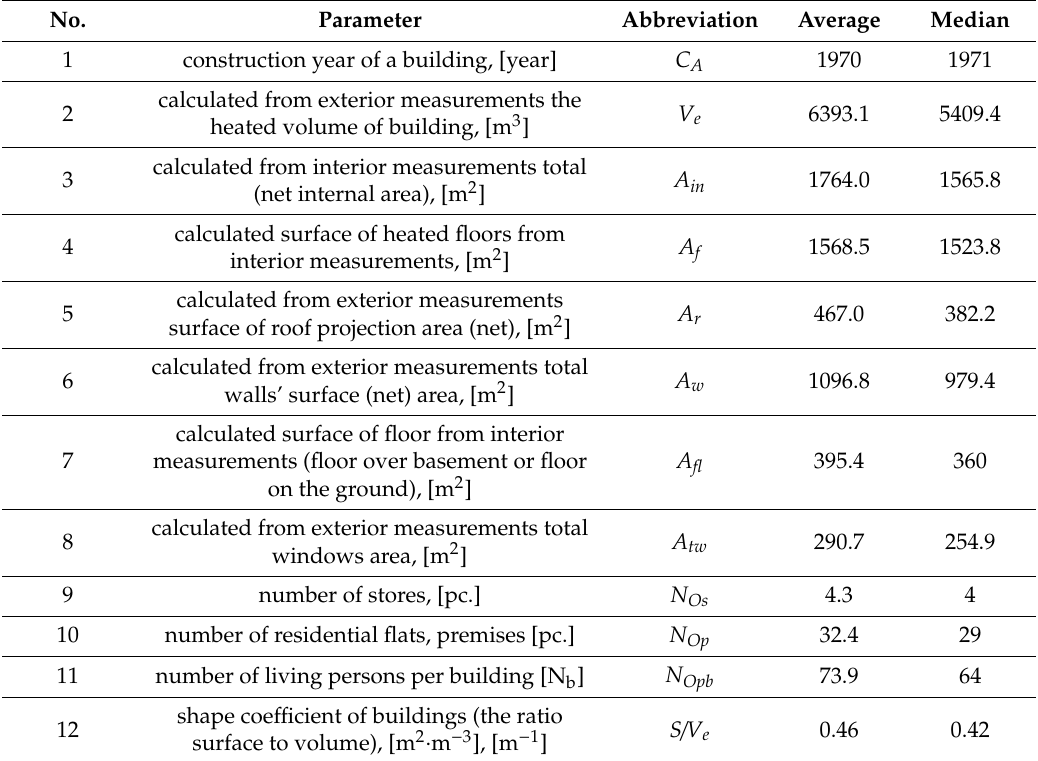
Table 1. Characteristics of potential variables influencing the energy needs of buildings undergoing thermal e ffi ciency